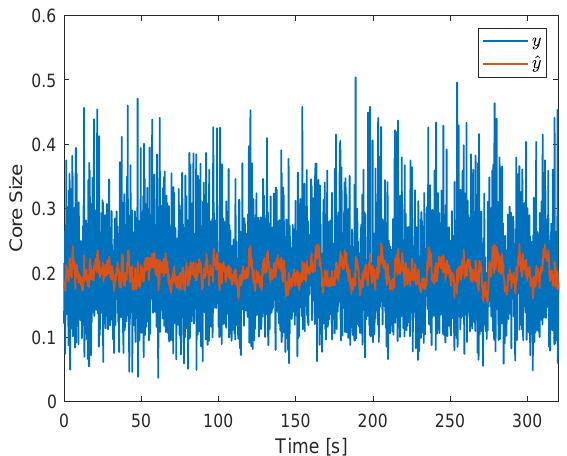
Figure 23. Controlled core size in the absence of external disturbances. In blue: original ERT signal. In orange: output of the low-pass filter ( ω f = 1 rad/s). Signals with standard deviation σ ( y ) = 0.0719 and σ ( ˆ y ) =